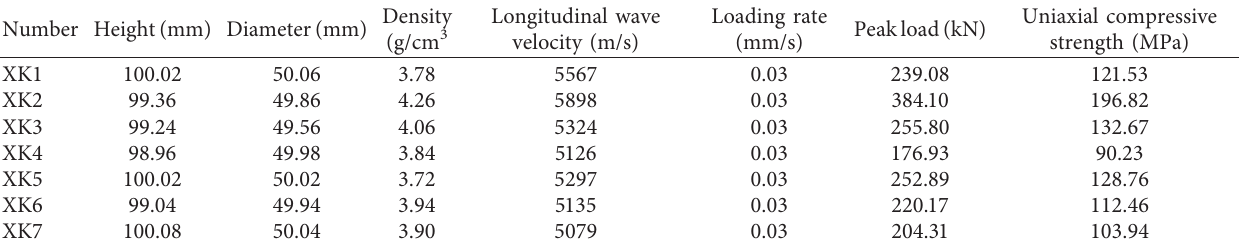
Table 1: Test scheme and results of deep skarn under uniaxial compression.